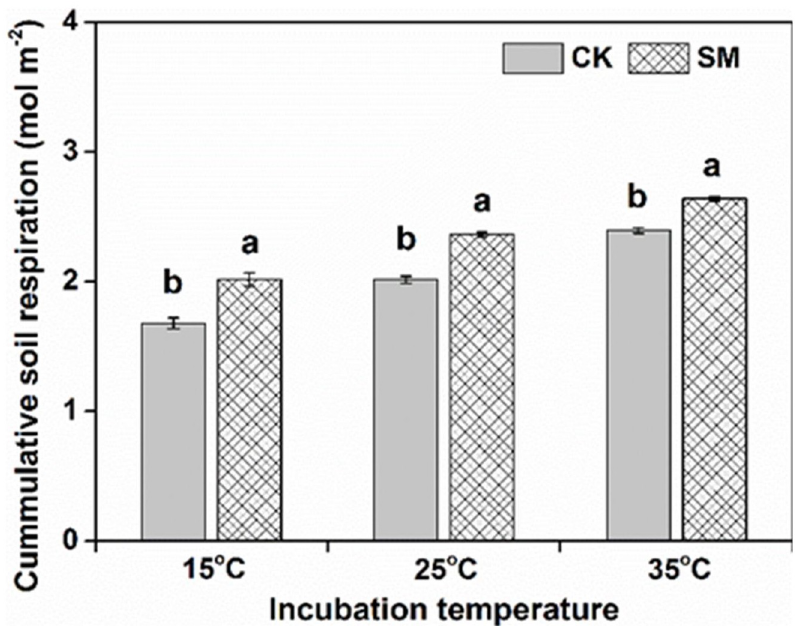
Fig 2. Cumulative soil respiration over the 60-day incubation under straw mulching and no mulching at different incubation temperatures. a CK: no mulching; SM: straw mulching. b Different lowercase letters indicate significant difference between straw mulching and no mulching.